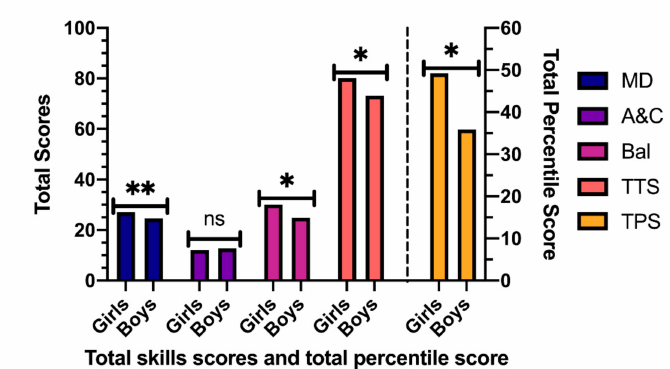
Figure 1. Total skill scores and total percentile score according to gender. MD: Manual dexterity; A&C: Aiming and Catching; Bal: Balance; TTS: Total Test Score; TP: Total Percentile. Note: * p < 0.001 different between Girls vs. Boys; ** p < 0.05 different between Girls vs. Boys; ns p > 0.005 no significative differences.